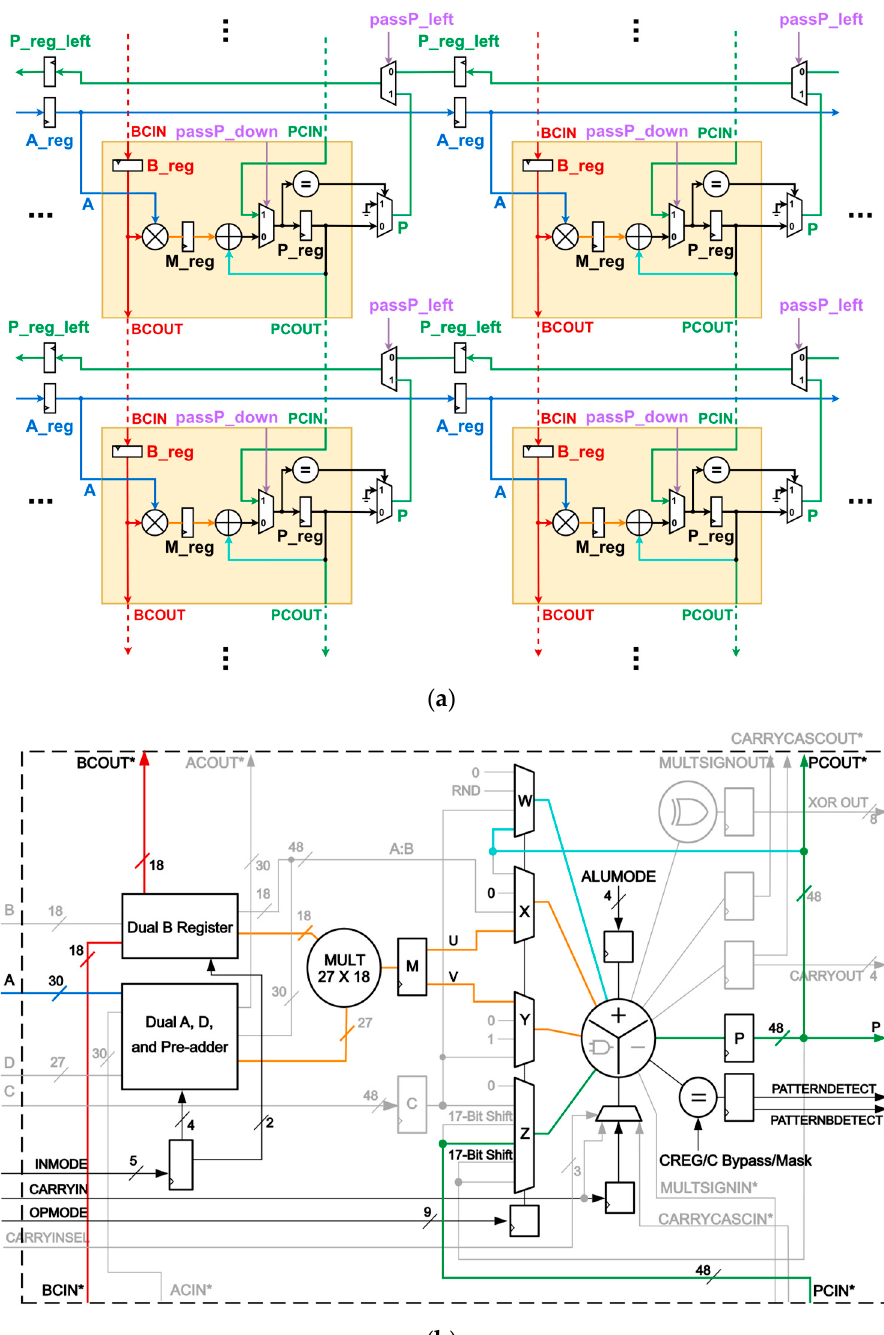
Figure 5. ( a ) A portion of the proposed systolic array, ( b ) schematic of the DSP48E2, while each cell is mapped on one DSP48E2 slice, and the datapaths used inside are colored. mapped on one DSP48E2 slice, and the datapaths used inside are